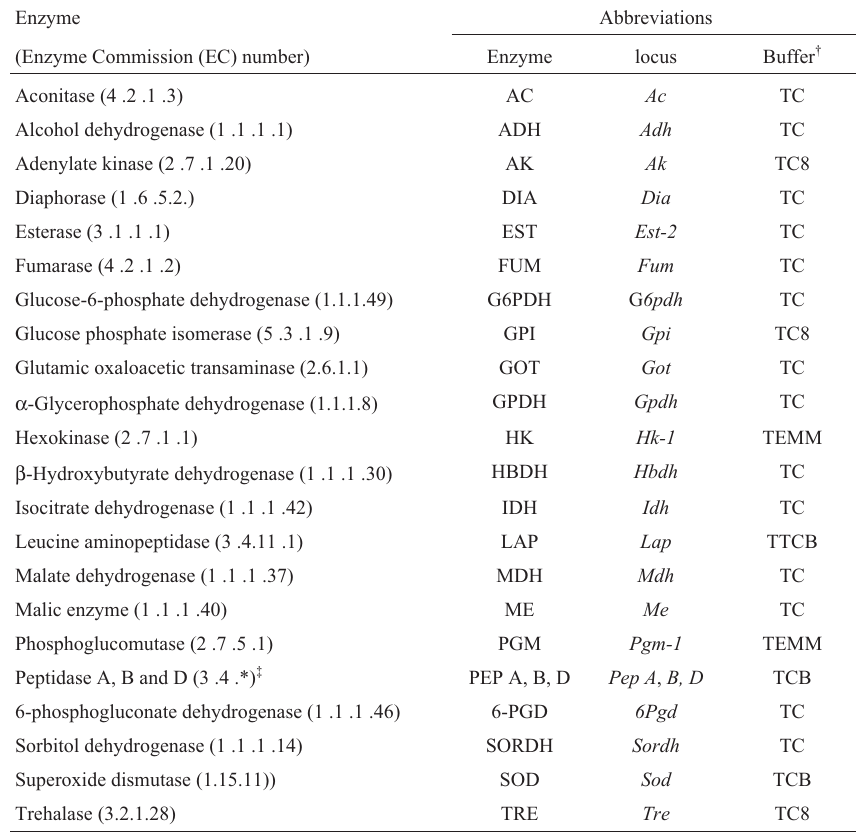
χ 2 χ 2 HW ) and homogeneity test ( hom ) values